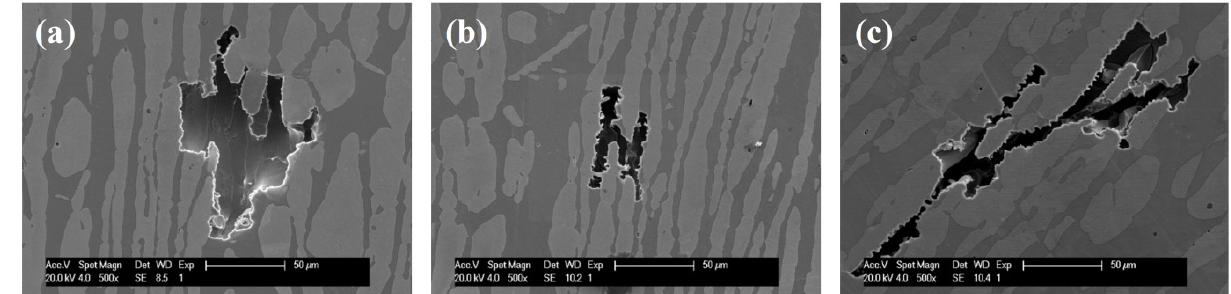
Figure 9. SEM morphologies of pittings formed on specimens annealed at different temperature for 30 min after the CPT test. ( a ) 1000 °C; ( b ) 1050 °C; ( c ) 1150